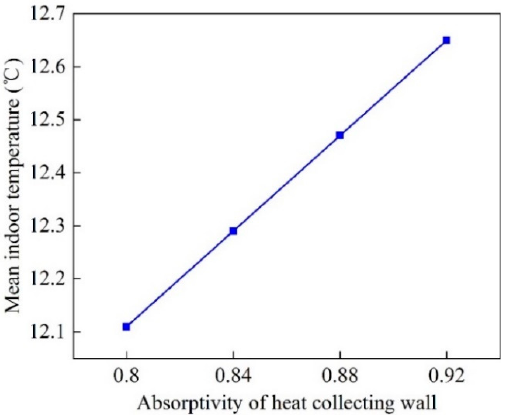
Figure 15. Indoor air temperature for different values of absorptivity of heat collecting wall.